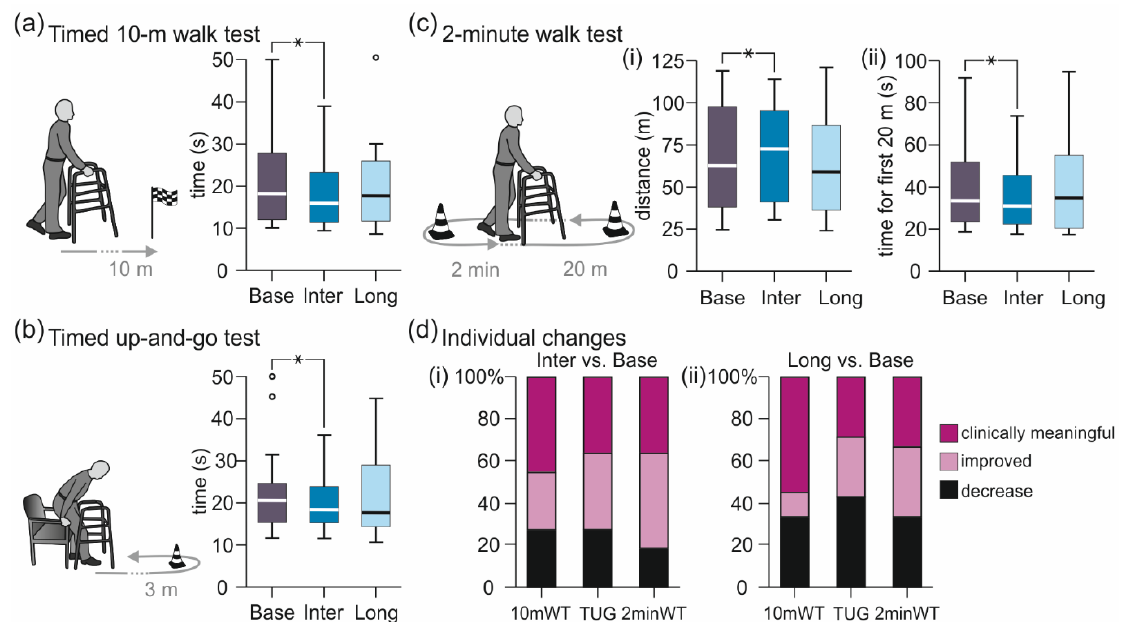
Figure 3. Intermediate and longer-lasting carry-over effects of transcutaneous spinal cord stimulation on walking function. Group results of the evaluations Base, Inter, and Long of ( a ) the timed 10-m walk test; ( b ) the timed up-and-go test; and ( c ) (i) distance of the 2-min walk test as well as (ii) time required to cover the first 20-m course length, illustrated by box plots. Bold horizontal lines within boxes are medians; boxes span the interquartile range. Whiskers extend to the lowest and largest values that are not outliers (illustrated as circles; see Methods). Brackets and asterisks denote significant results of post-hoc pairwise comparisons (*, p < 0.05). ( d ) Individual changes in walk tests in (i) Inter and (ii) Long compared to Base. Stacked bar charts of the timed 10-m meter walk test (10mWT), the timed up-and-go test (TUG) and the 2-min walk test (2minWT) show percentage of changes classified as clinically relevant improvement (10mWT, increase of walking speed by ≥ 0.05 m/s; TUG, time reduced by ≥ 15%; and 2minWT, distance increased by ≥ 6.8 m), improvement, and decrease. Base, baseline evaluation comprising two assessments conducted ~24 h and immediately pre-intervention; Inter, evaluation of intermediate carry-over effects comprising two assessments conducted immediately and two hours post-intervention; Long, evaluation of longer-lasting carry-over effects conducted ~24 h post-intervention.